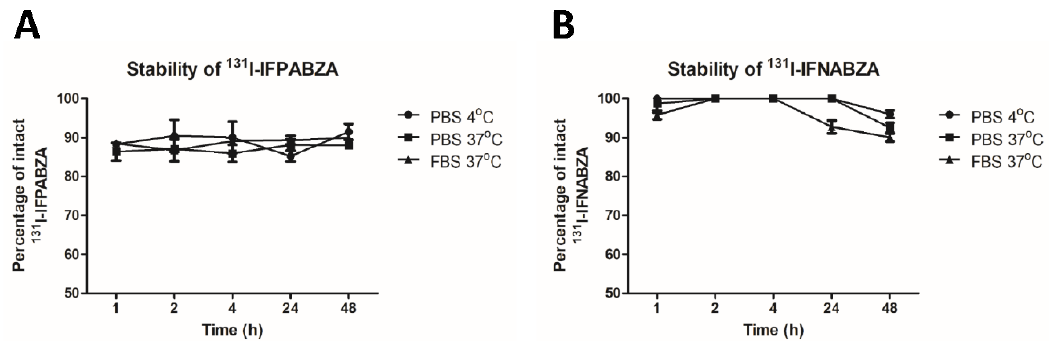
Figure 3. In vitro stability of ( A ) 131 I-IFPABZA and ( B ) 131 I-IFNABZA in either PBS or fetal bovine serum (FBS).